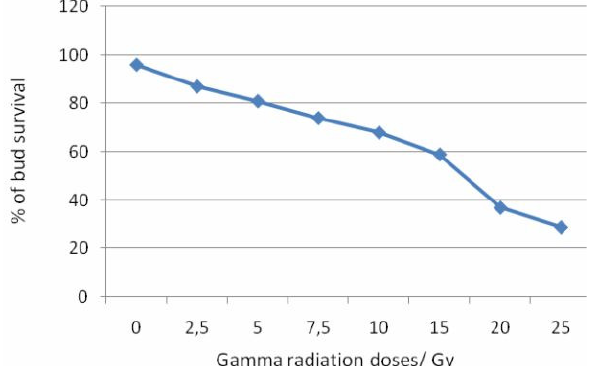
Fig. 6a. Effect of gamma radiation doses on % of bud survival in haploid plants